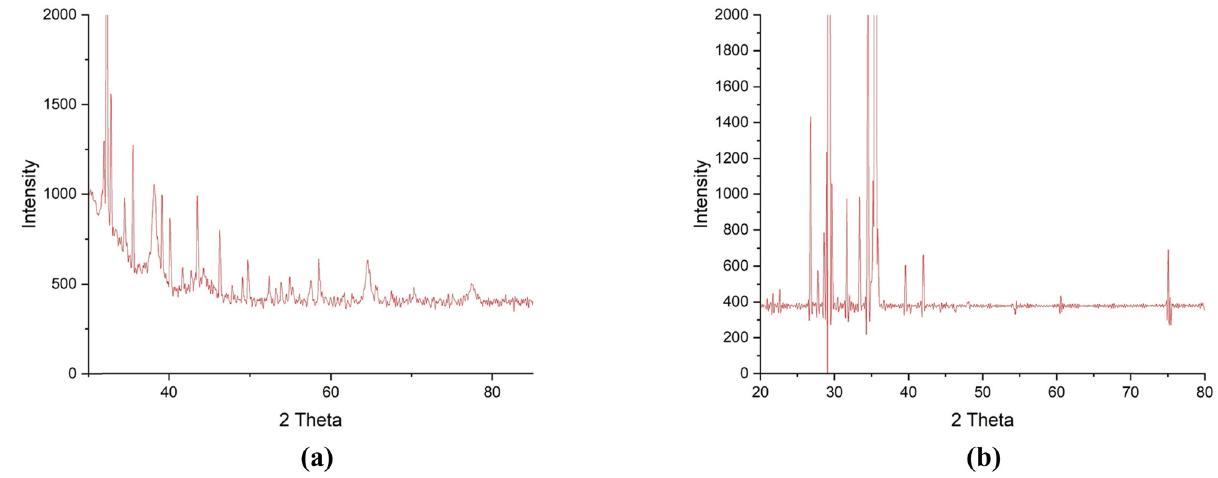
Figure 8: XRD pattern of AgNPs synthesized with starch ( a ) and with dry microalgae biomass ( b )